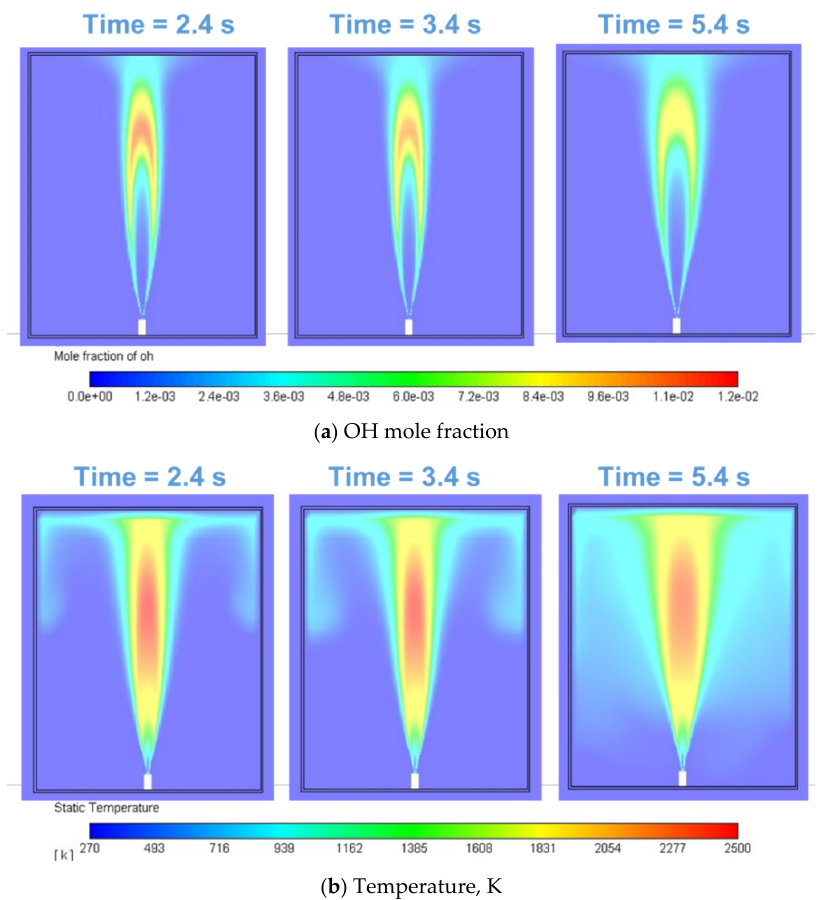
Figure 4. ( a ) Simulated hydroxyl mole fraction and ( b ) temperature distributions in the plane x = 0 perpendicular to the enclosure walls with vents for Test No.14 ( 𝑃 (cid:3020) = 11.78 MPa, 𝑚(cid:4662) = 11.37 g/s, Number of experimental vents = 3), Δ t = 0.34 ms, CFL = 50.